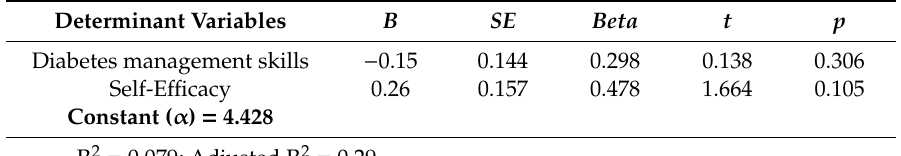
Table 2. Influence of mediating variables on diabetes self-management.